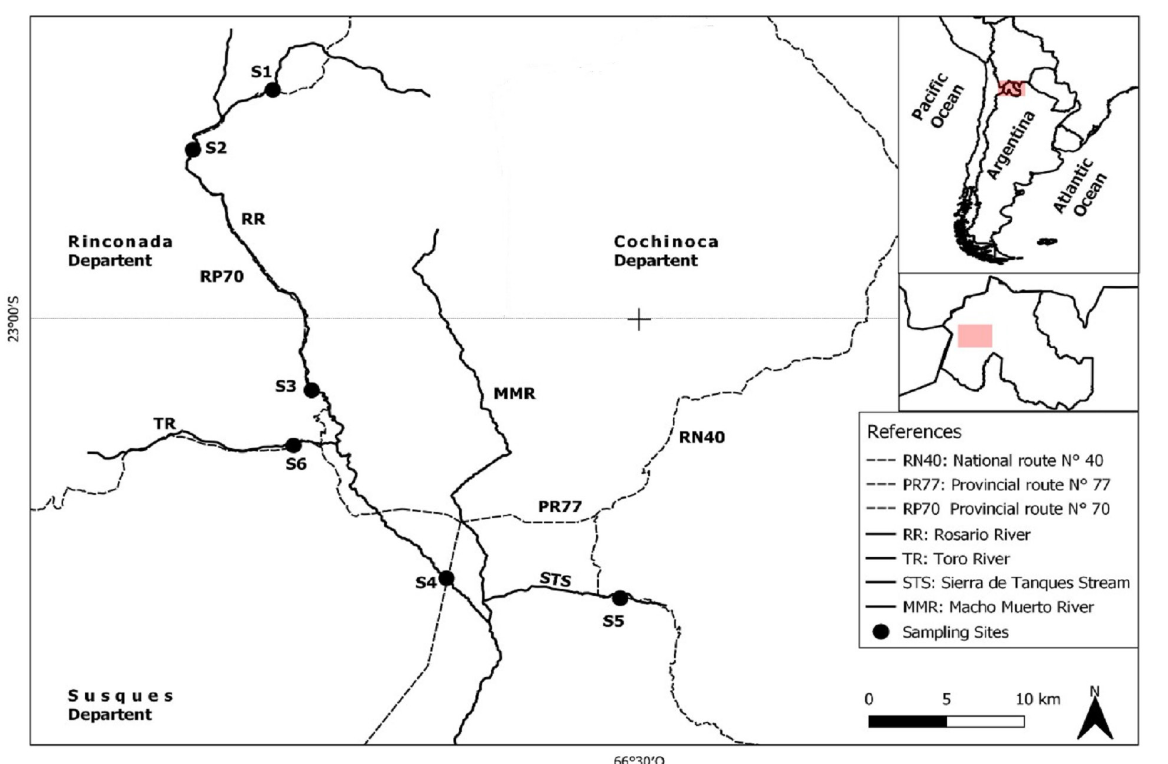
Figure 1. Location of Rosario, Sierra de Tanques and Toro rivers and